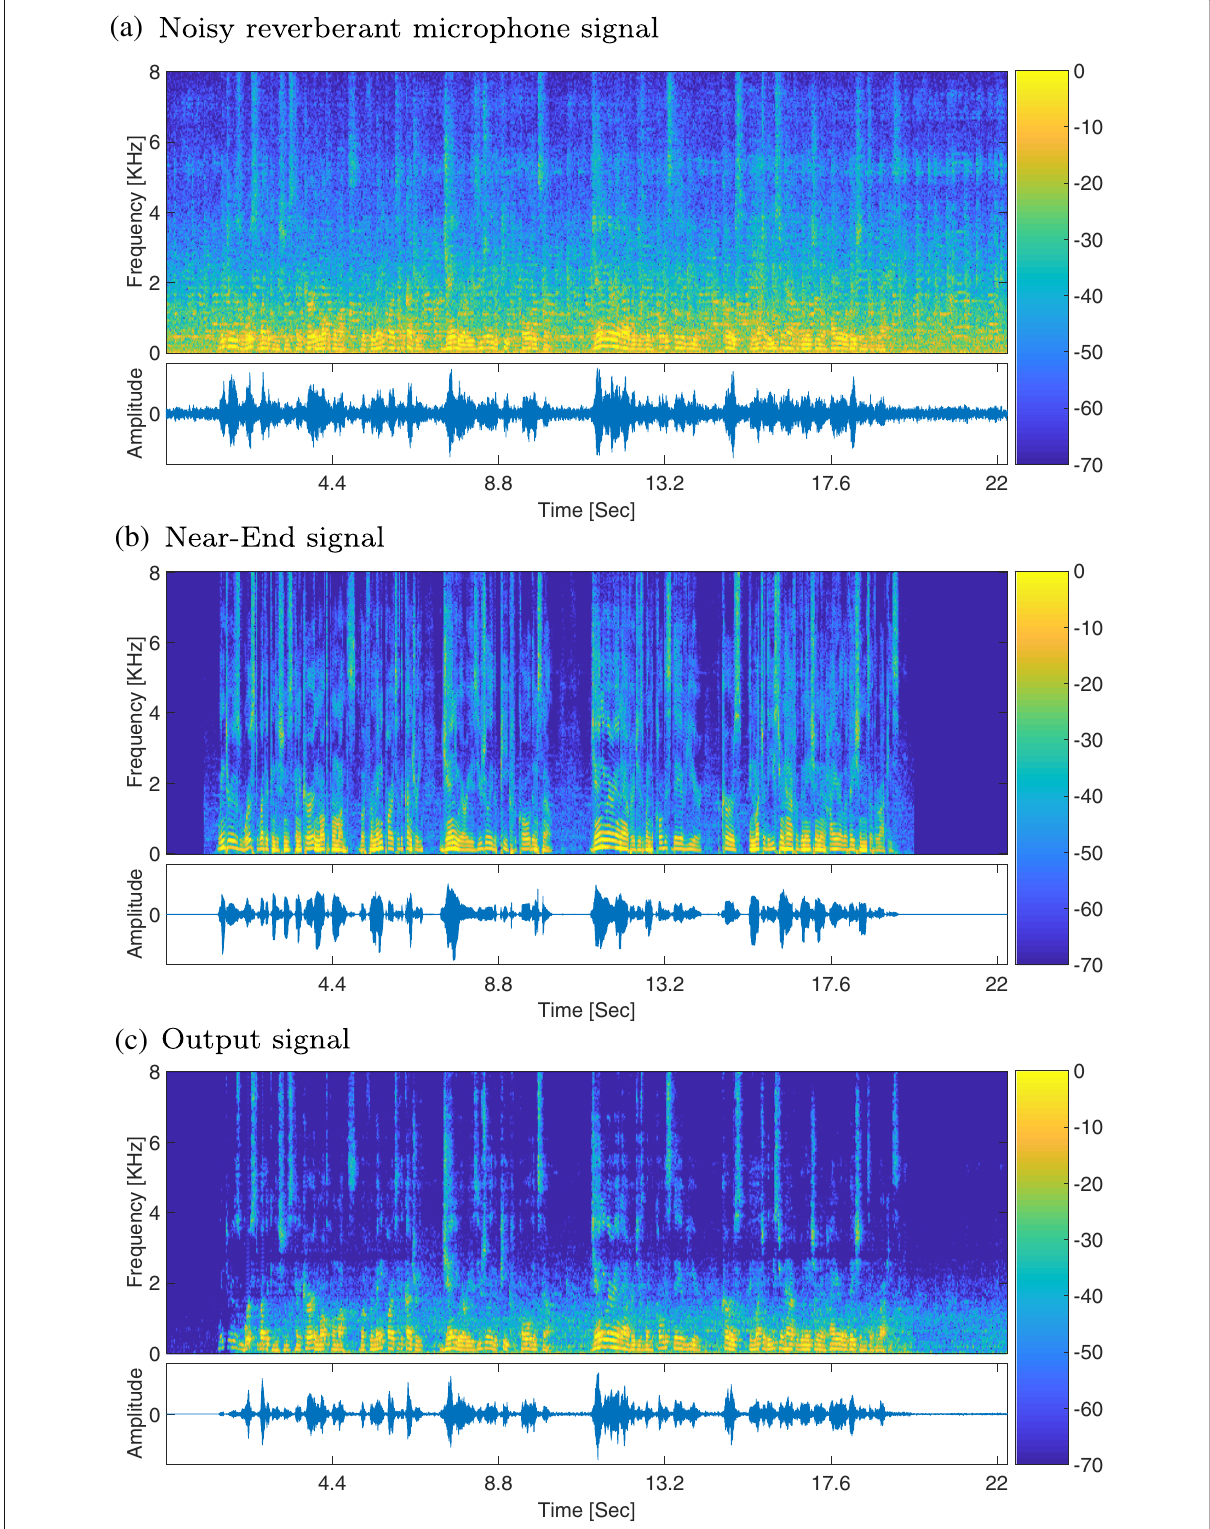
Fig. 5 Spectogrames and waveforms of scenario #2, T 60 = 650 ms. The reverberant near-end signal cannot be extracted in Scenario